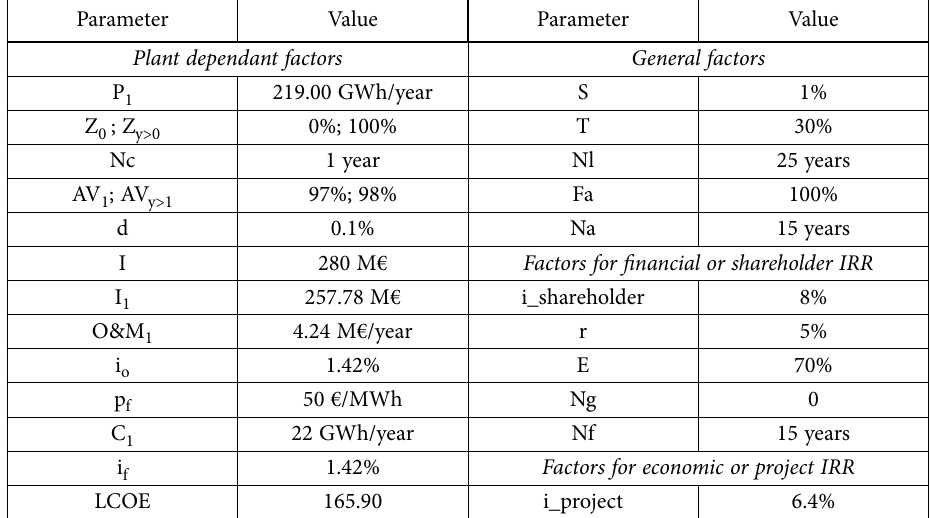
Table 3. Measurement of LCOE: results for CSP plants in Spain Parameter Value Parameter Value Plant dependant factors General